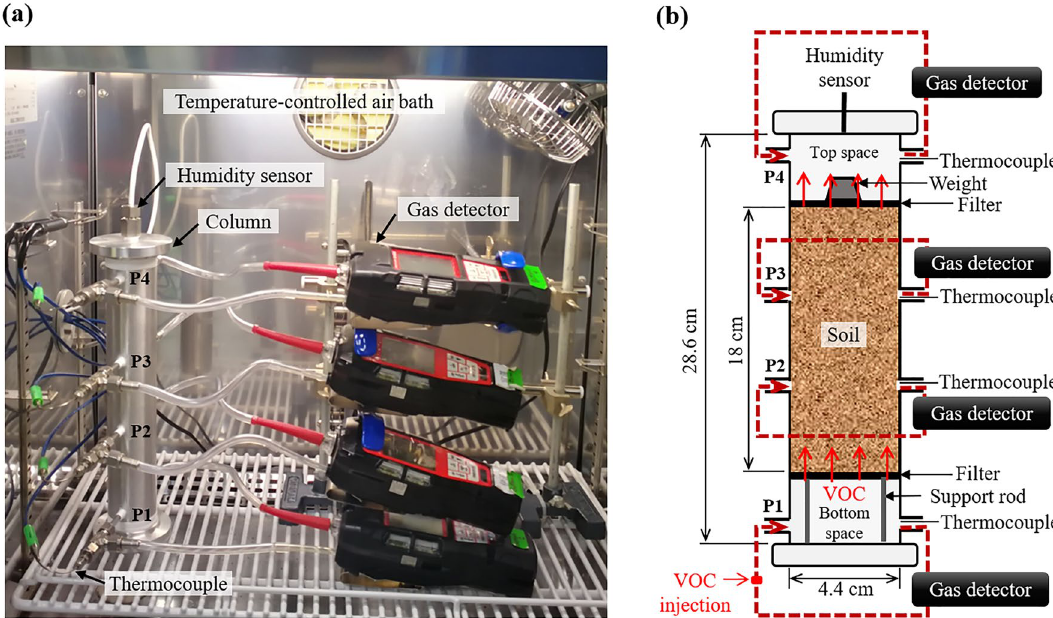
Figure 1. ( a ) Photograph and ( b ) schematic illustration of the experimental system for the vertical vapor-phase diffusive transport of a volatile organic compound (VOC) through a soil